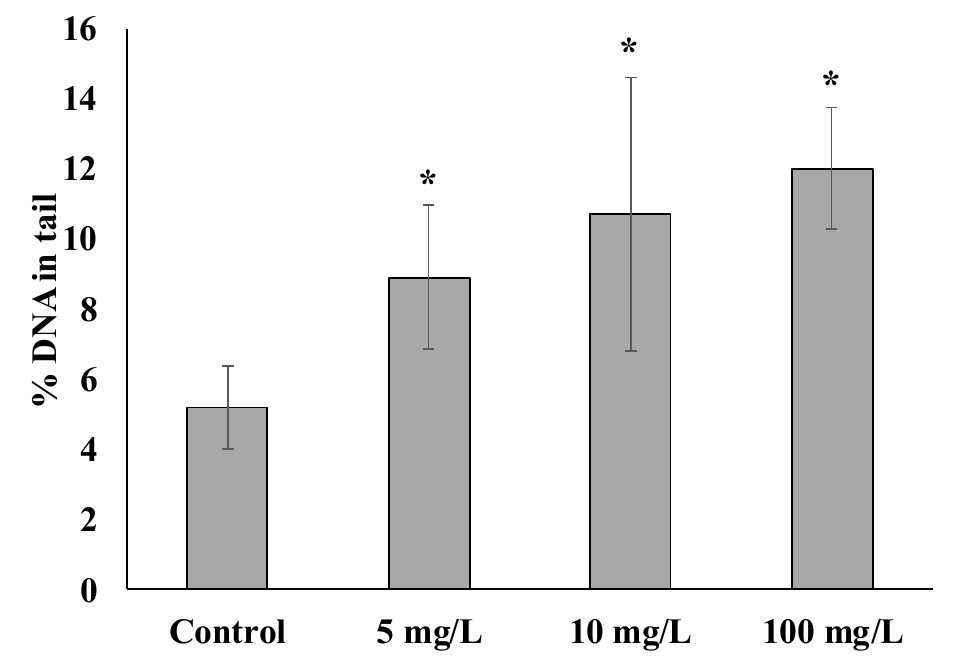
Figure 1. DNA damage of sperm exposed with different concentrations of NPs (mean ± standard deviation, n = 3). * Difference from the control is significant ( p < 0.05).